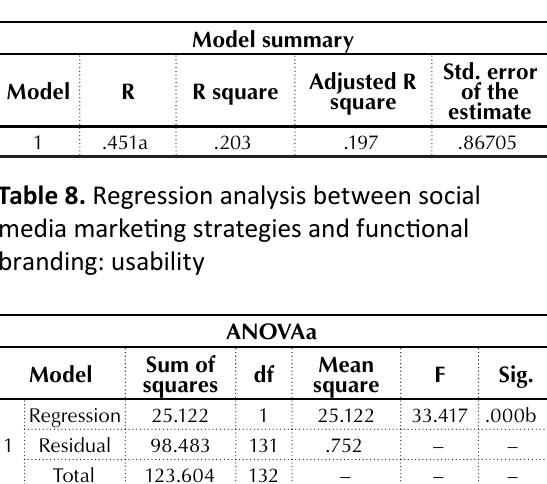
Table 7. Correlation analysis between social